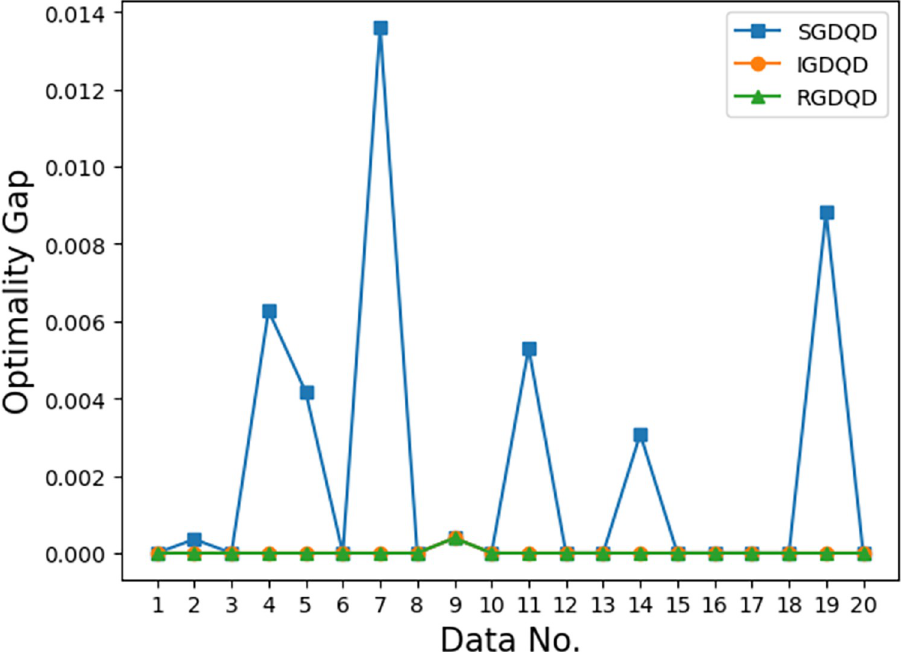
Fig 8. Comparison of optimality gaps for Q = 15000.